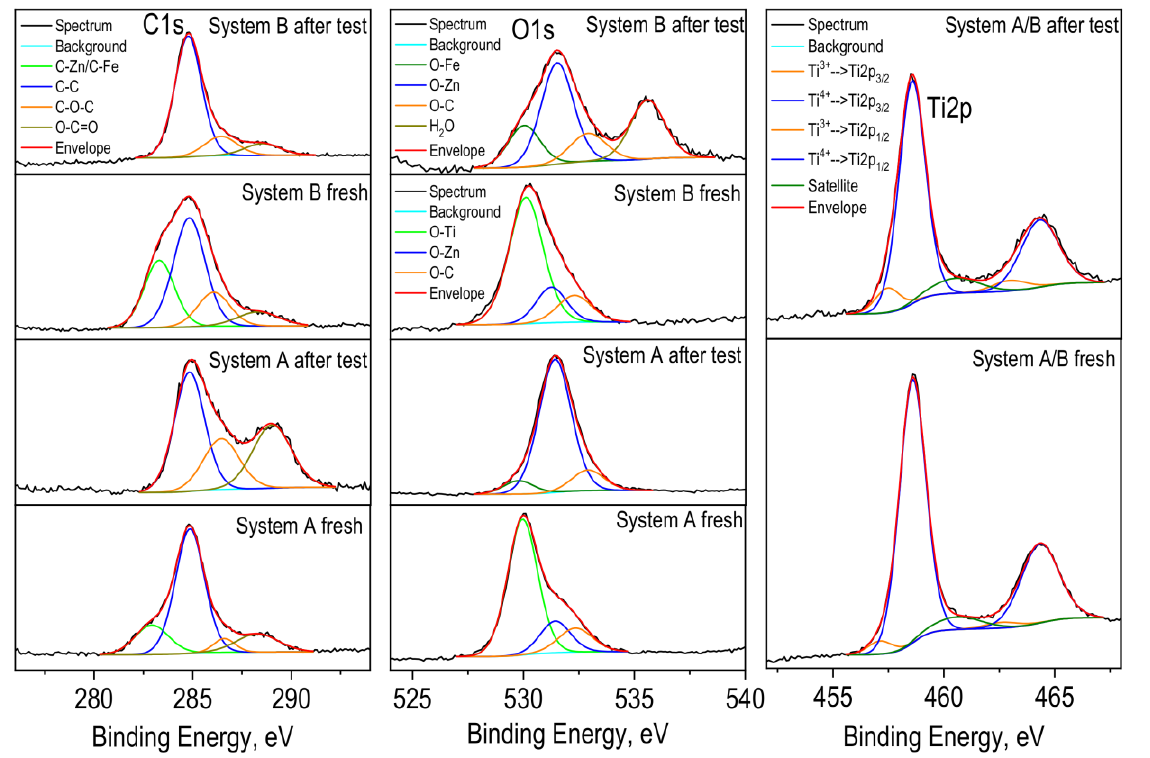
Figure 10. Deconvolution of C1s, O1s and Ti2p photoelectron spectra of the Systems A and